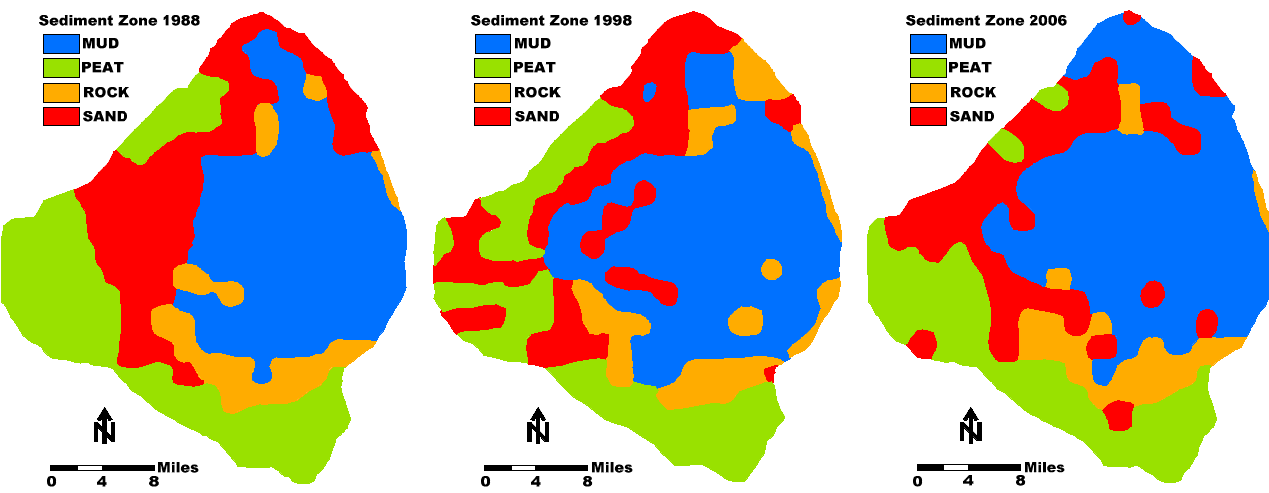
Figure 5. Sediment zone maps of Lake Okeechobee from 1988, 1998, and 2006 as compiled by Yan and James [31]. Note that the positioning systems used during these studies changed from LORAN to GPS. Therefore, some inherent geo localization errors occurred when comparing the maps.